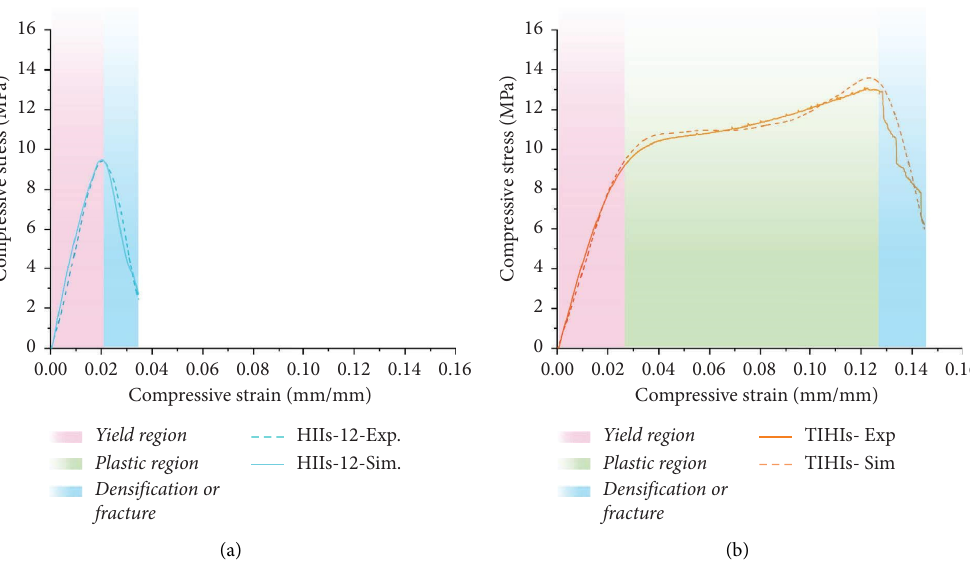
Figure 8: Te regions in compressive stress-strain distribution for (a) HII-12 and (b) TIHI